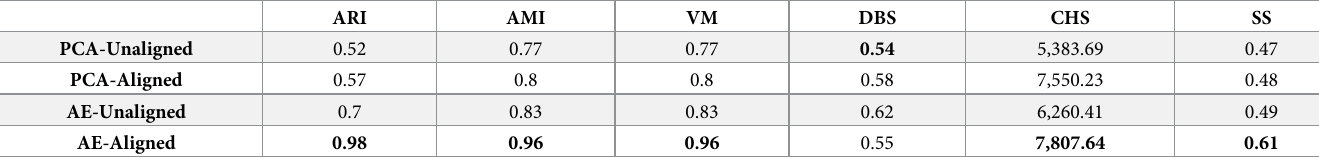
Table 3. Impact of the number of epochs through comparison of different number of epochs on the results of the AE variant on Sim4. The metrics show that increas- ing the number of epochs does not necessarily increase the performance of the model as the best performance across all metrics is obtained at 50 epochs, the values indicat- ing the highest performance for each metric have been bolded. ARI AMI VM DBS CHS SS Epochs = 50 0.98 0.97 0.79 Epochs = 100 0.91 0.66 0.98